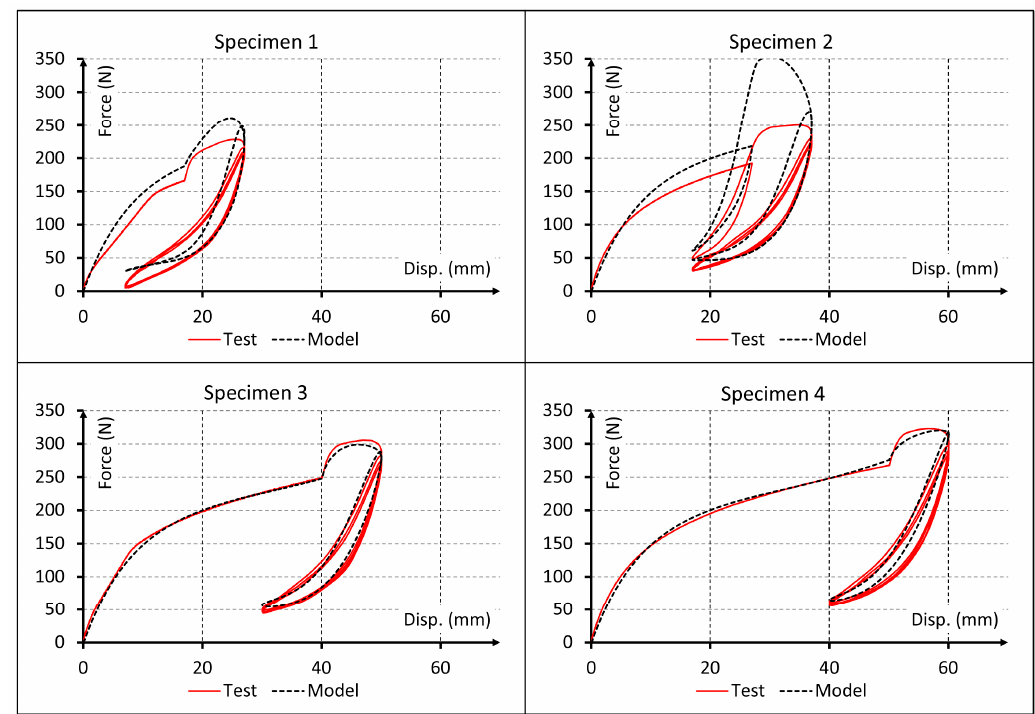
Figure 7. Comparison for first cycles between experimental data and force-displacement curves simulated using the proposed model.